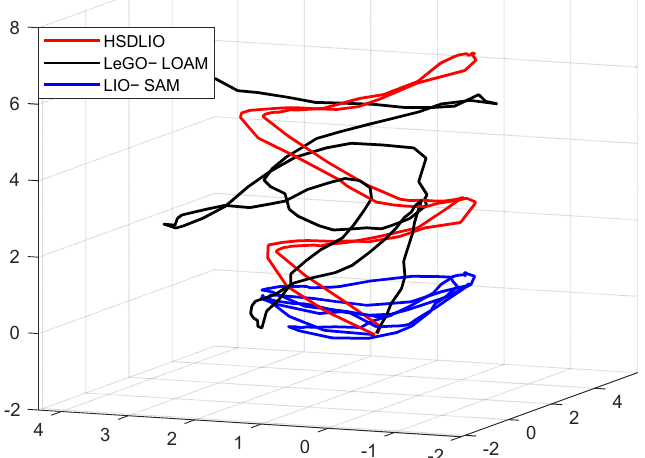
Figure 12. Comparison of LeGO-LOAM, LIO-SAM, and HSDLIO trajectories. The red line is the trajectory of HSDLIO, the blue line is the trajectory of LIO-SAM, and the black line is the trajectory of LeGO-LOAM. While LeGO-LOAM’s trajectory drifted and LIO-SAM’s trajectory produced cumulative errors in the z direction, the trajectory of HSDLIO approximated the real trajectory.